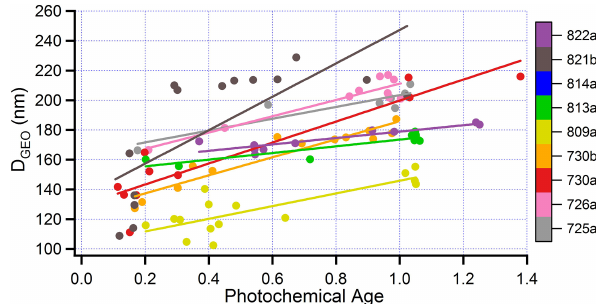
Figure 15. D GEO as a function of photochemical age for eight flights. Calculation of D GEO from FIMS measurements given in text. Format similar to Fig. 10.